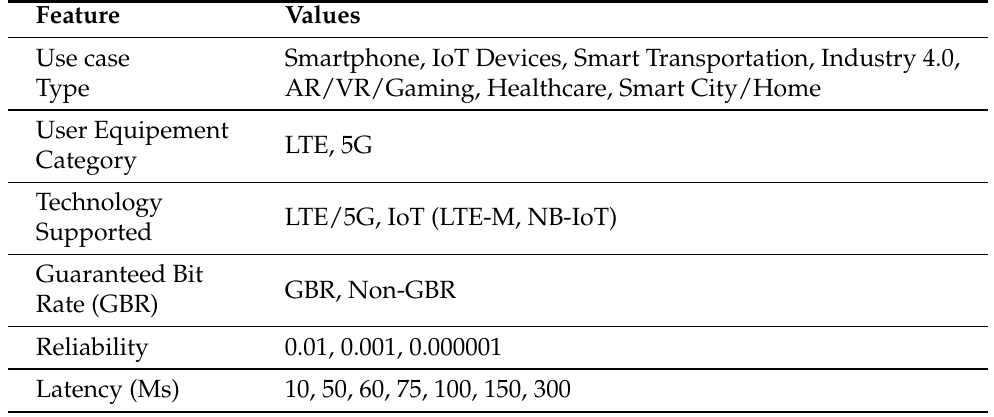
Table 4. An Overview of DeepSlice